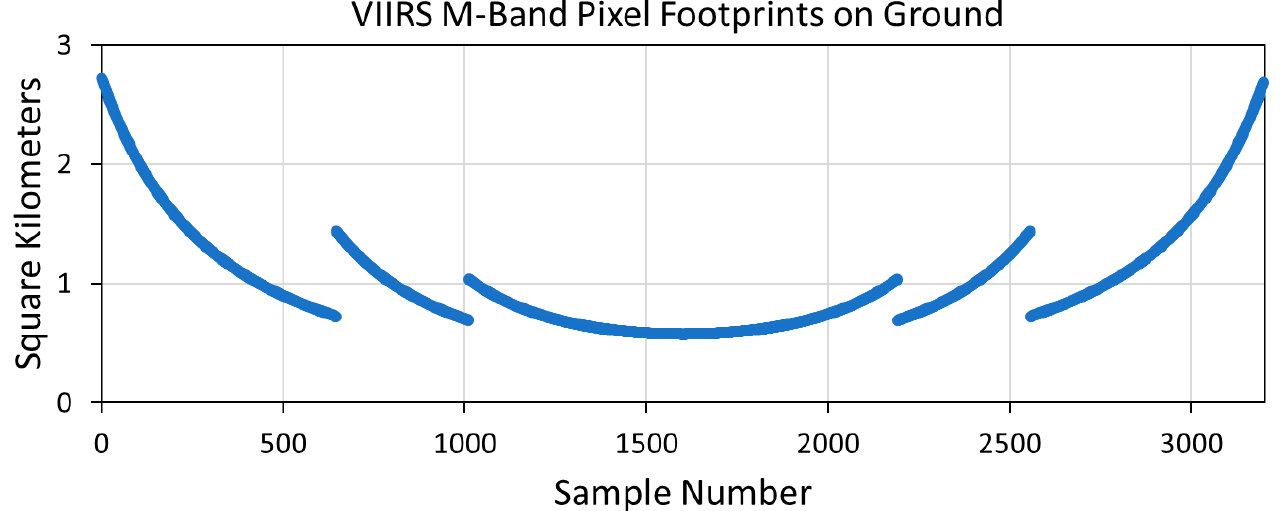
Figure 1. VIIRS M-band pixel footprints vary as a function of sample position.